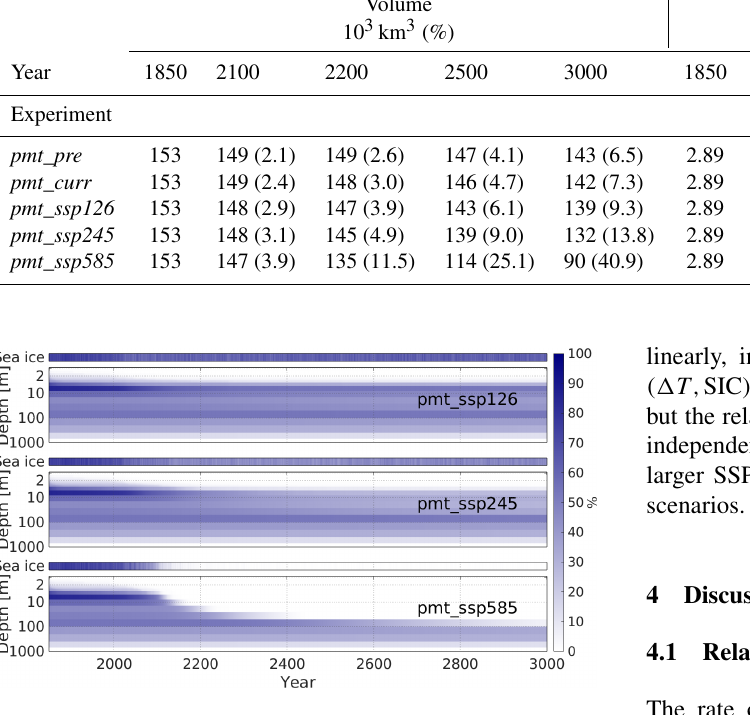
Figure 6. Vertical distribution of SSPF ice saturation (main panels) and sea ice concentration (top panels) for the scenario experiments. Yearly averages for the 242 points which contained ice in the initial conditions (1850). “Depth” is measured downward from the sea